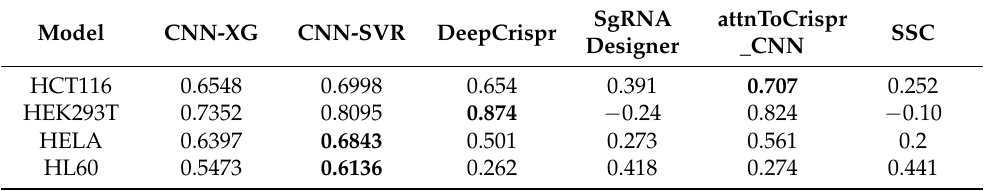
Table 4. Spearman correlations for test scenario 3.